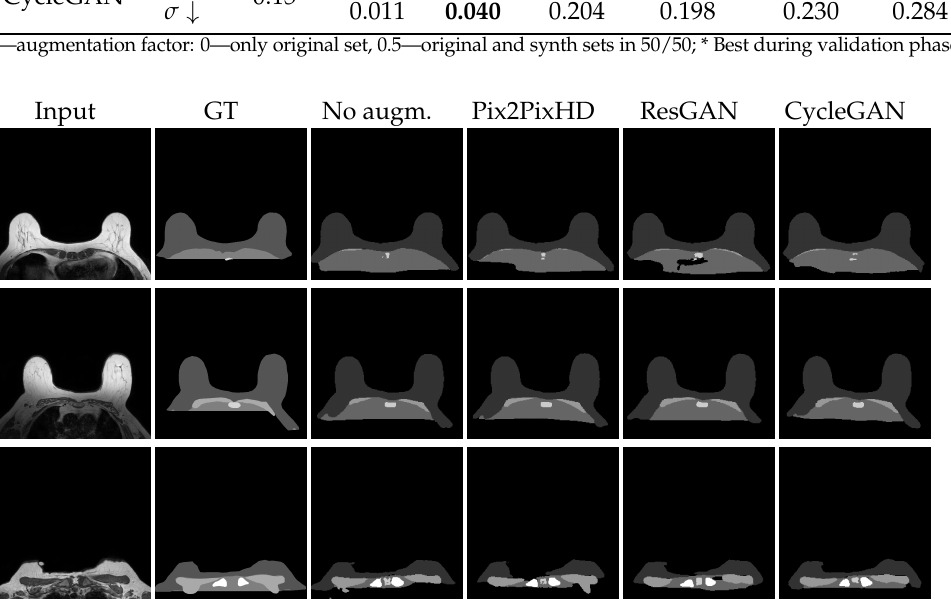
Figure 7. Best visual test results for the segmentation U-Net, trained with the respective synthsets ResGAN and Pix2PixHD with BS8. CycleGAN with BS1 and Experience Replay. Further results